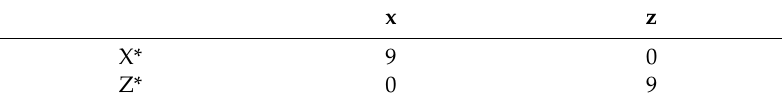
Table 2. The 2 × 2 matrix obtained when comparing the sources “X” and “Z”.